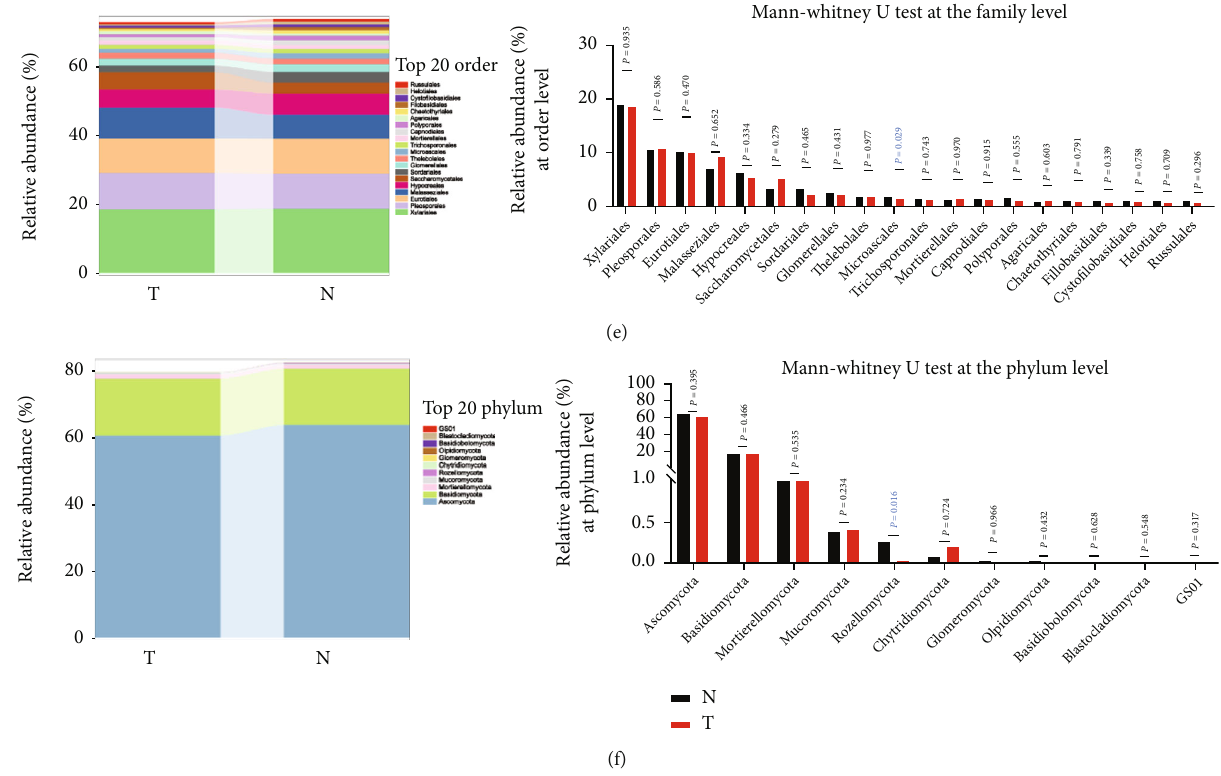
Figure 2: Di ff erential taxa composition between the tumor and normal group in GC. (a) The fungal composition in primary tumor and corresponding paired normal mucosal tissues from 61 GC patients was displayed at di ff erent classi fi cation levels, including the phylum, class, order, family, genus, and species levels; (b – f) the abundance and distribution of the top 20 fungal taxa were described between the two groups at the class, family, genus, order, and phylum levels and were analyzed by the Mann – Whitney U